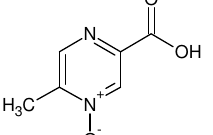
Figure 1 . Chemical structure of acipimox.